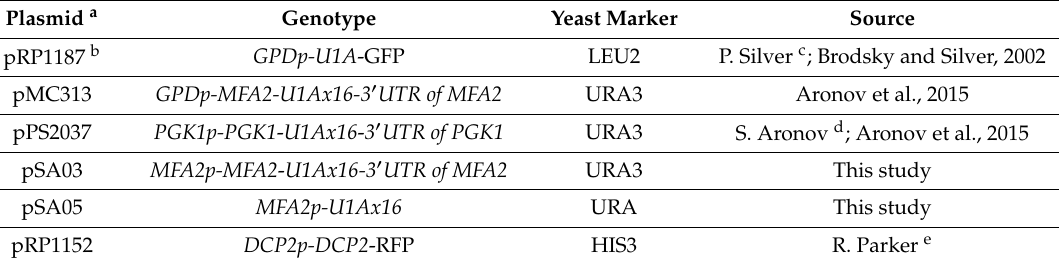
Table 6. Plasmids used in the